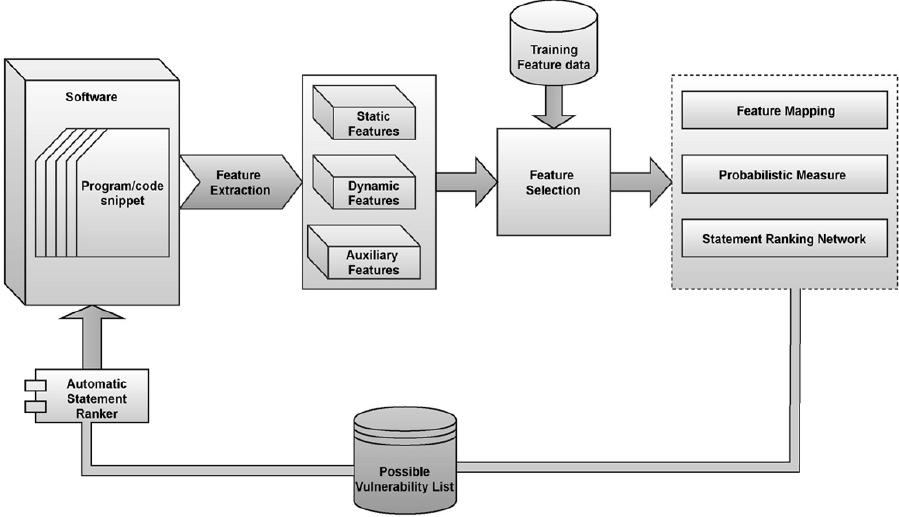
Figure 2. Represents the block diagram of the proposed fault localization